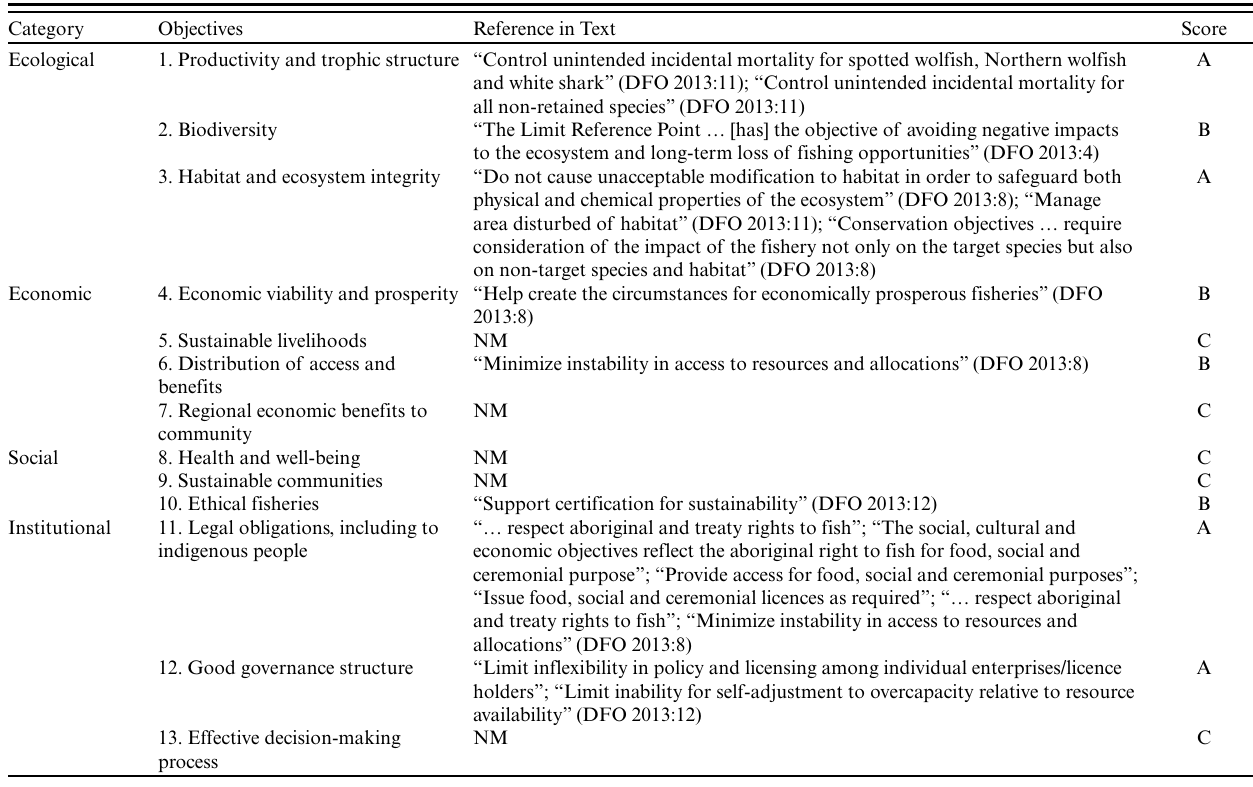
Table 4 . Desktop Canadian Fisheries Research Network evaluation of the 2013 Herring Plan (Department of Fisheries and Oceans [DFO] 2013). NM, no mention.